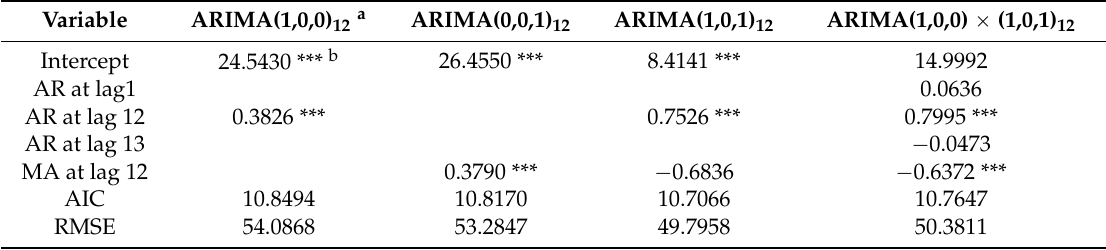
Table 5. The estimation results of ARIMA model for Vibrio parahaemolyticus outbreak series: univariate models b .